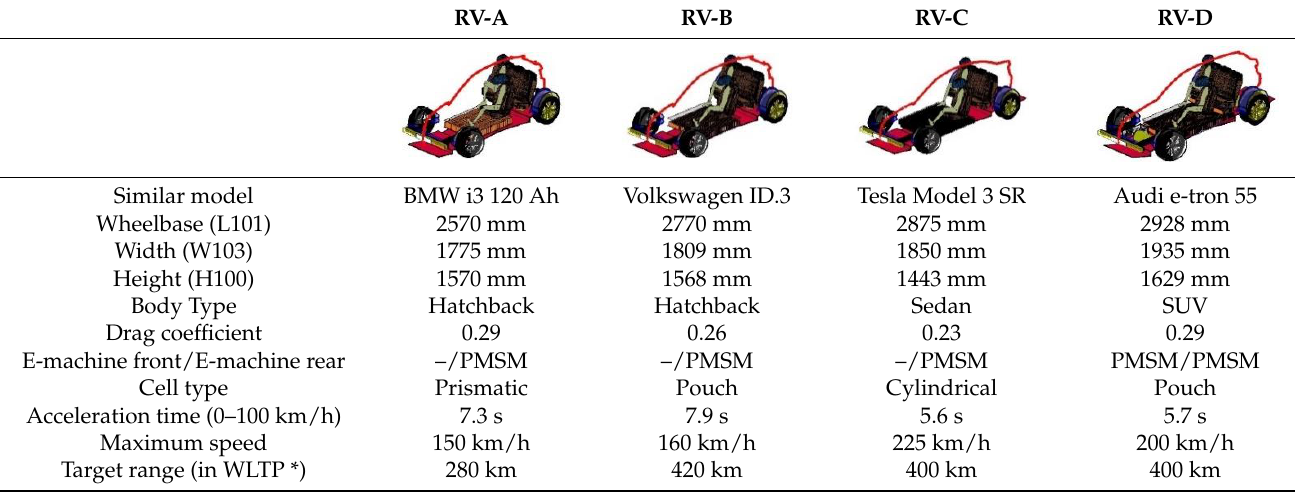
Table 4. Selected key characteristics of the RVs’ portfolios.